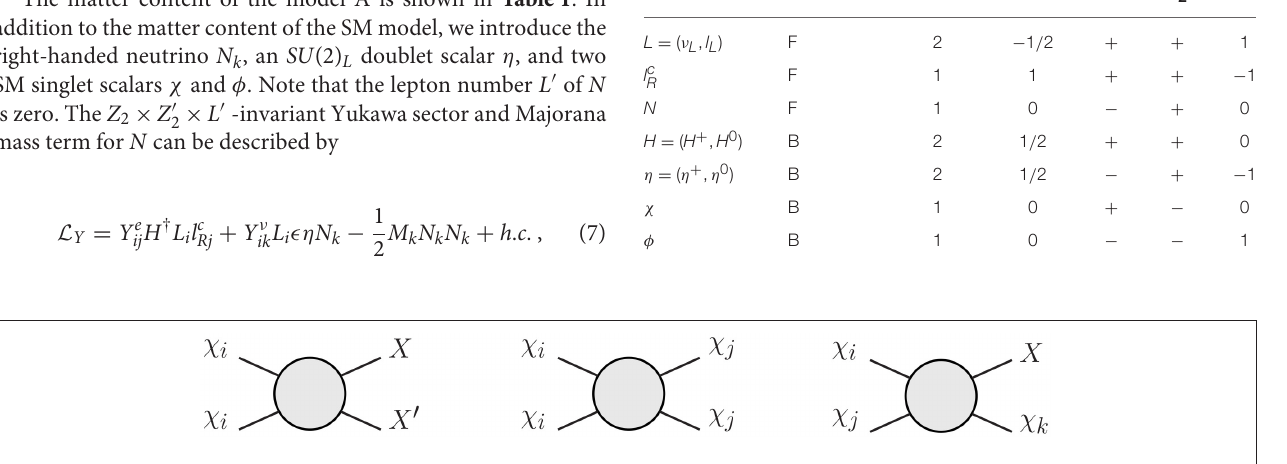
FIGURE 1 | Standard annihilation (Left) , DM conversion (Middle) and semi-annihilation (Right) .